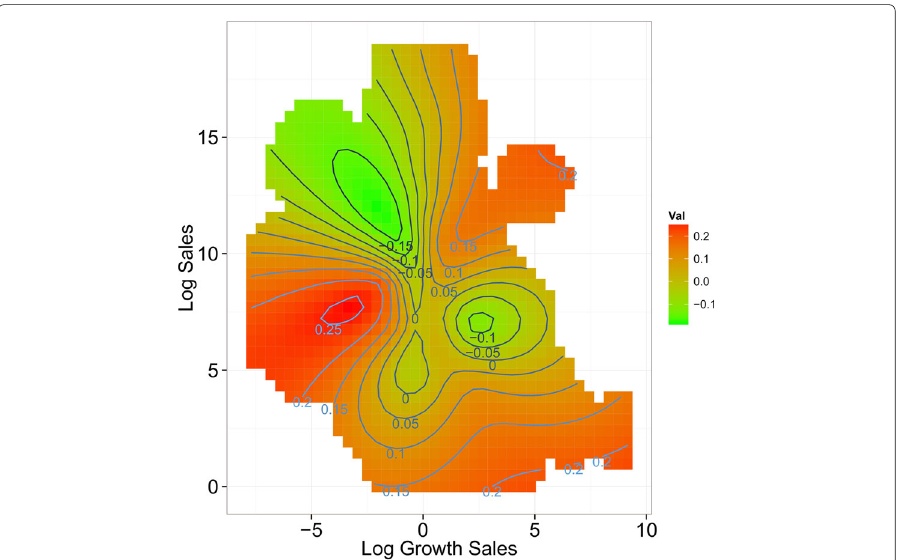
Fig. 1 ( Coloronline ) Contour plot showing the log growth rate of the following year to the current log growth rate and the current size for each firm. The contour was estimated using two-dimensional